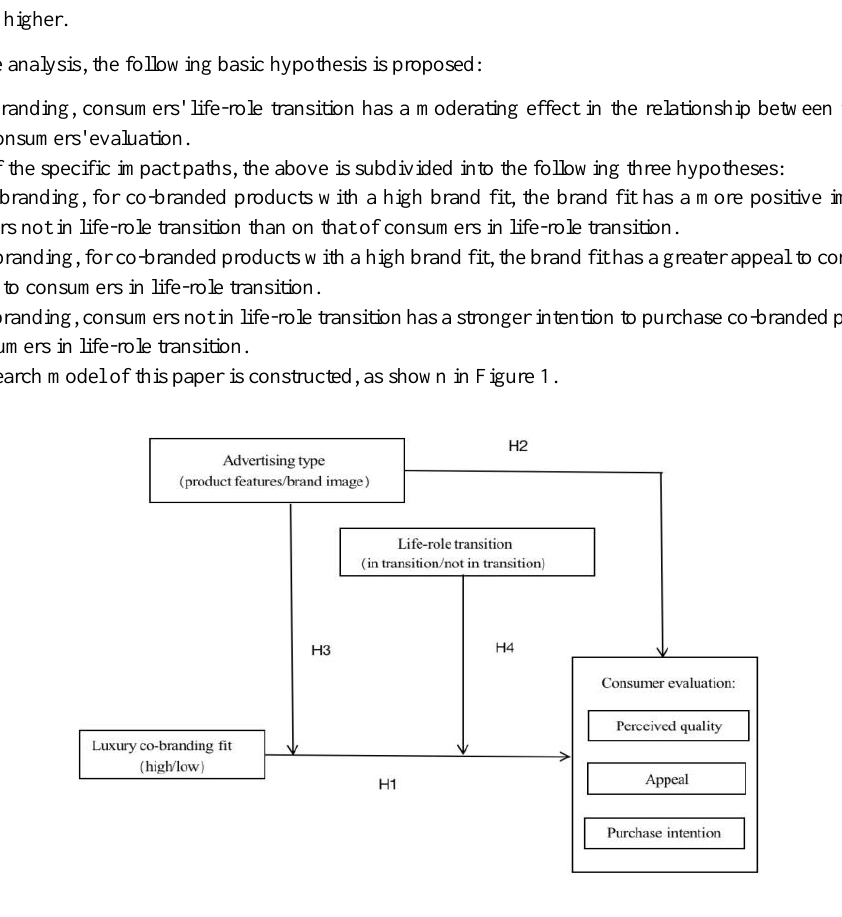
Figure 1: Research model of consumer evaluation in luxury